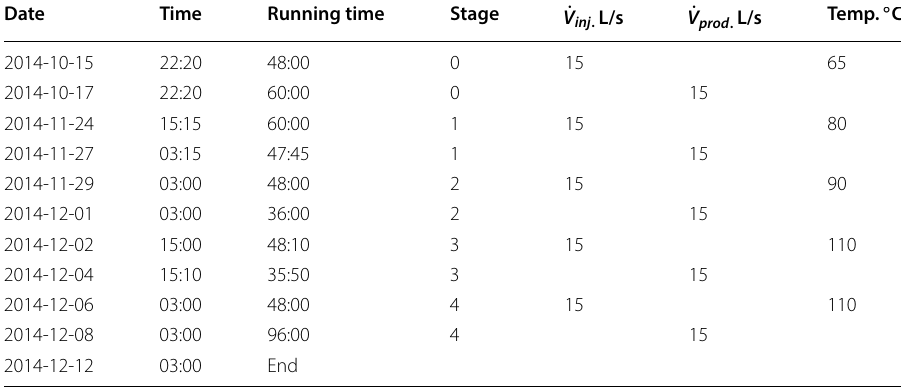
Table 1 Breakdown of the heat storage test. Ueckert and Baumann